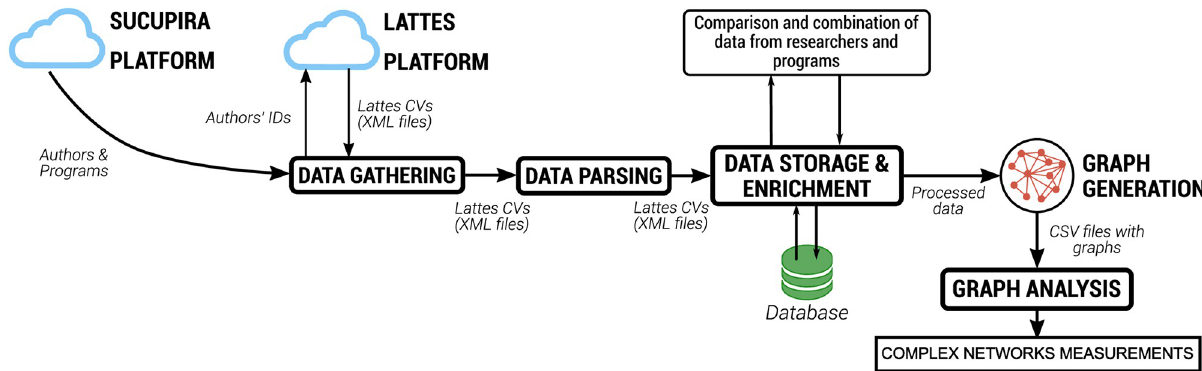
Fig 1. Process flow. Clouds show internet data access. Blocks in bold represent processes. Artifacts generated by each process are described next to the arrows that show the directions of the flow.